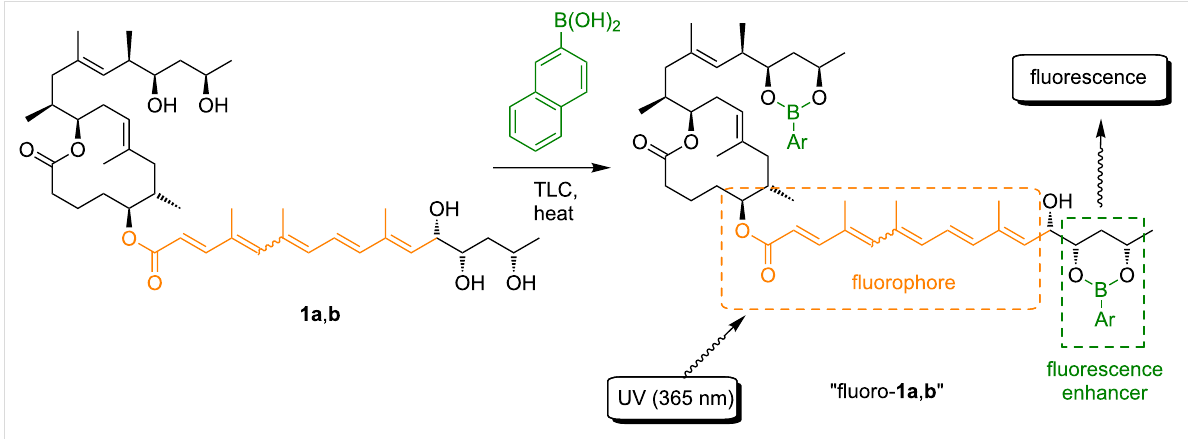
Figure 4: Schematic illustration of Kishi’s improved mycolactone TLC detection method exploiting derivatization with 2-napthylboronic acid as a fluo- rescence